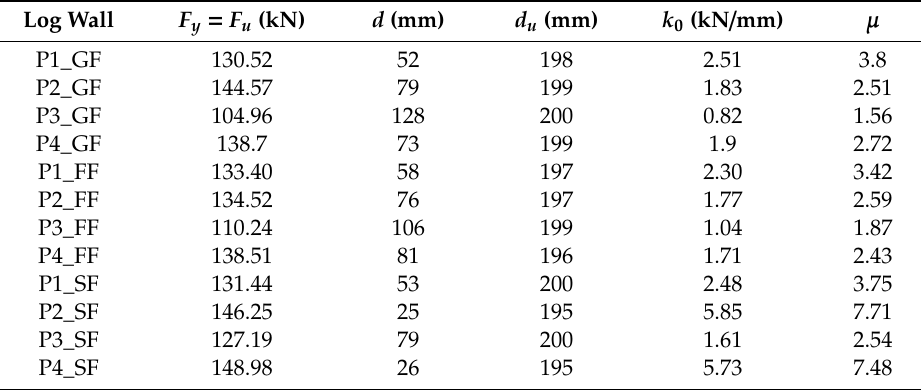
Table 3. Shear-wall backbone